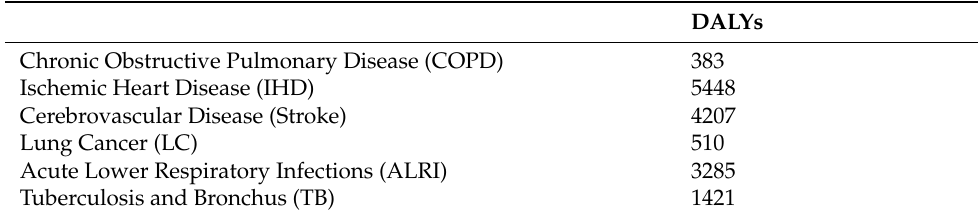
Figure 4. Calculation flow in solar power estimation (Created by the authors). Table 2. Total DALYs of the most critical diseases in UB, Mongolia